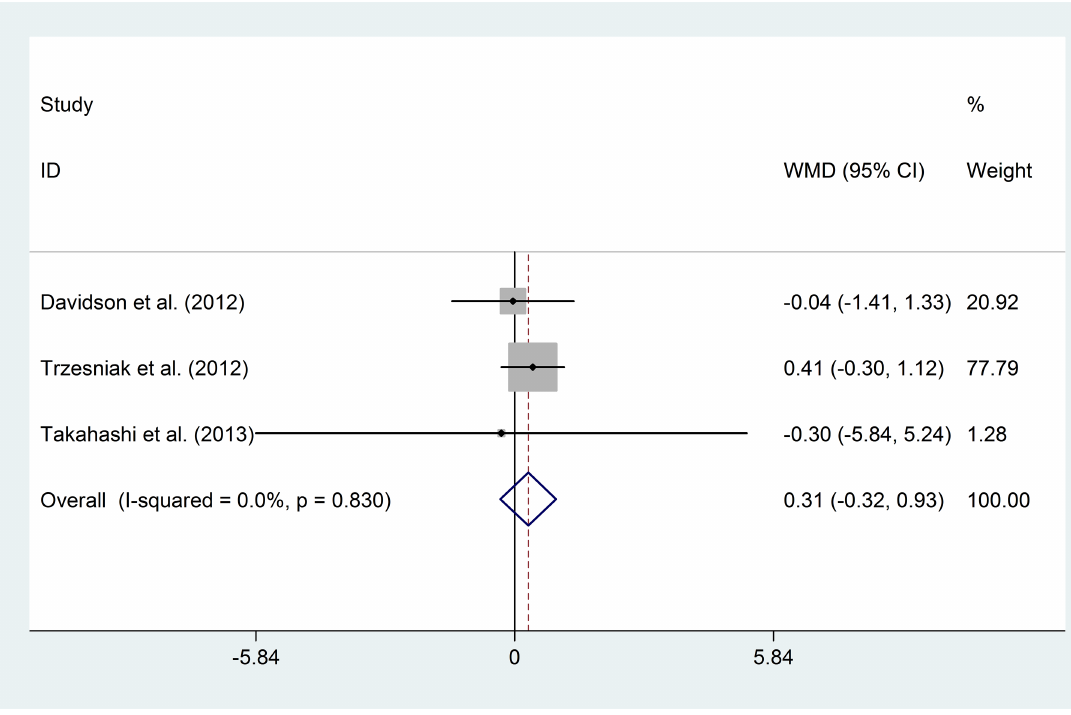
Fig 10. Increasesin the CSP length in the FEP patients and healthy